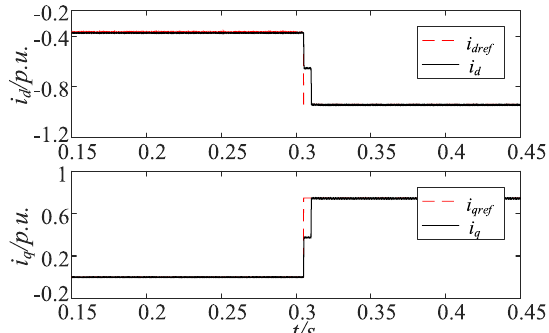
Fig. 13 dq -axis current when the voltage drops in the inverter state